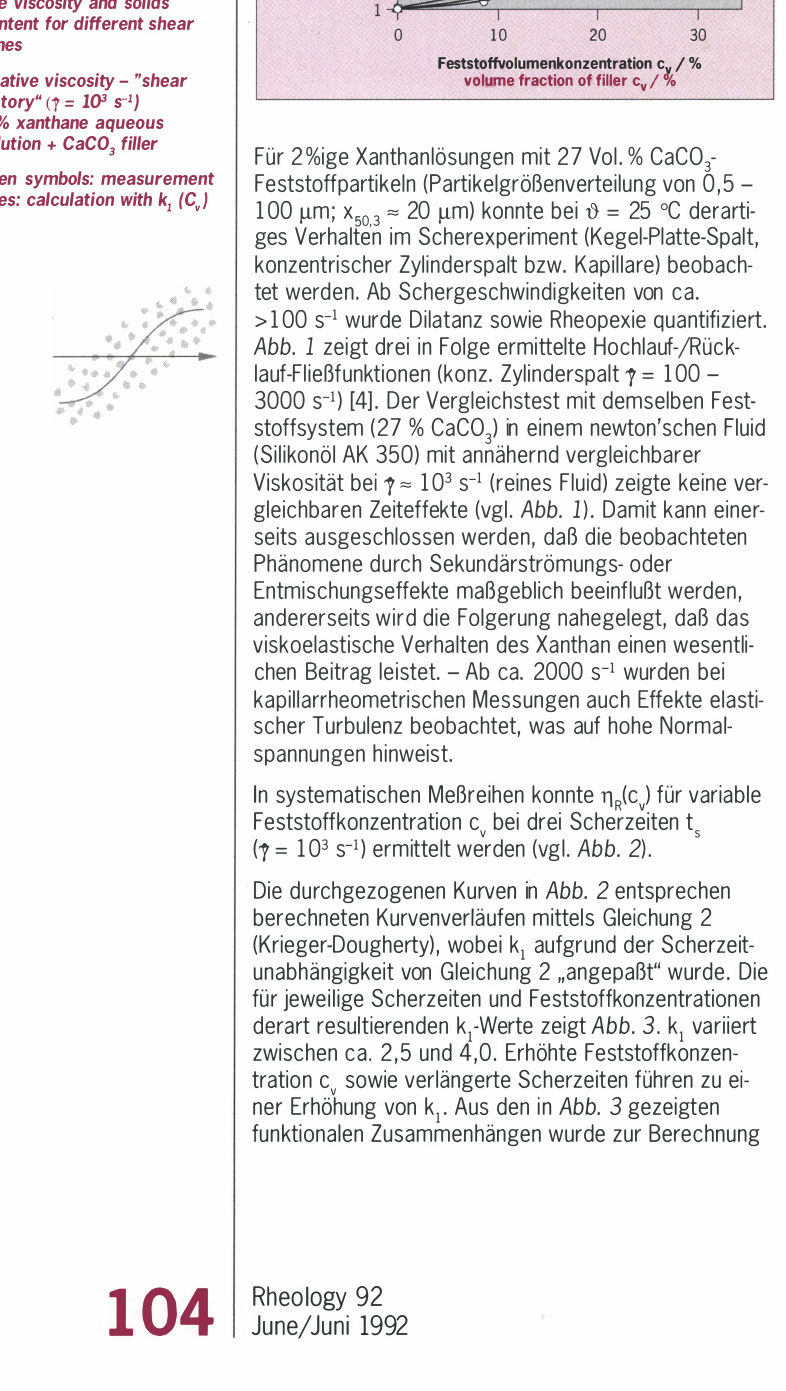
Fig. 3: k1 values for different shear times and solids contents Shape factor k1 versus filler volume fraction c , (2 % xanthane + CaC03 filler} - variable "shear history" • Scherzeit/shear time 1 80 s / 1 80 s I I .!::::.. Scherzeitjshear time 720 s(720 s • Scherzeit/shear time 1080 s/1 080 s 10 20 30 0 Feststoffvolumenkonzentration cv I % volume fraction of filler cv 1 %